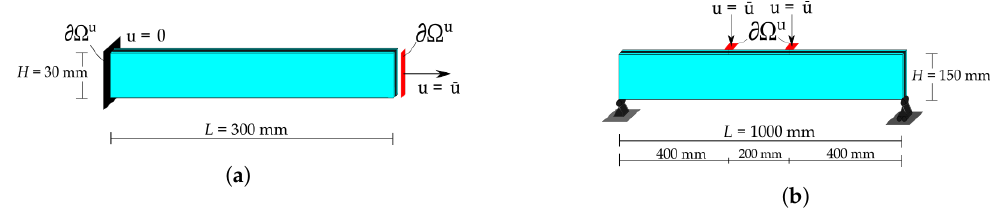
Figure 2. Test set-ups: ( a ) Unidirectional traction test (UD test) set-up. ( b ) Four-point bending test (FPB test)